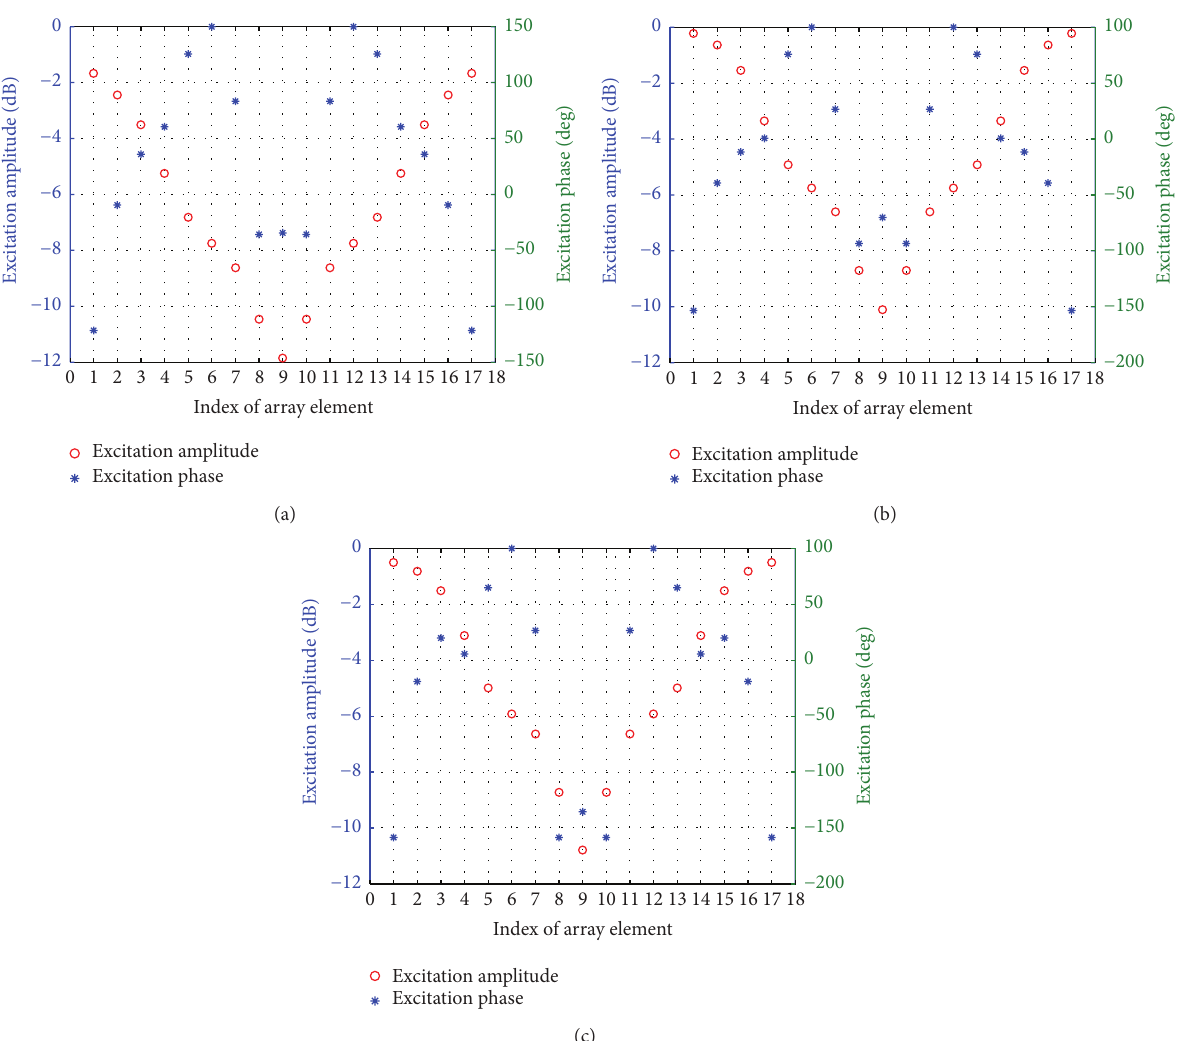
Figure 2: Excitation distributions of FTP synthesis. (a) AAP method, (b) WARP method, and (c) proposed method.